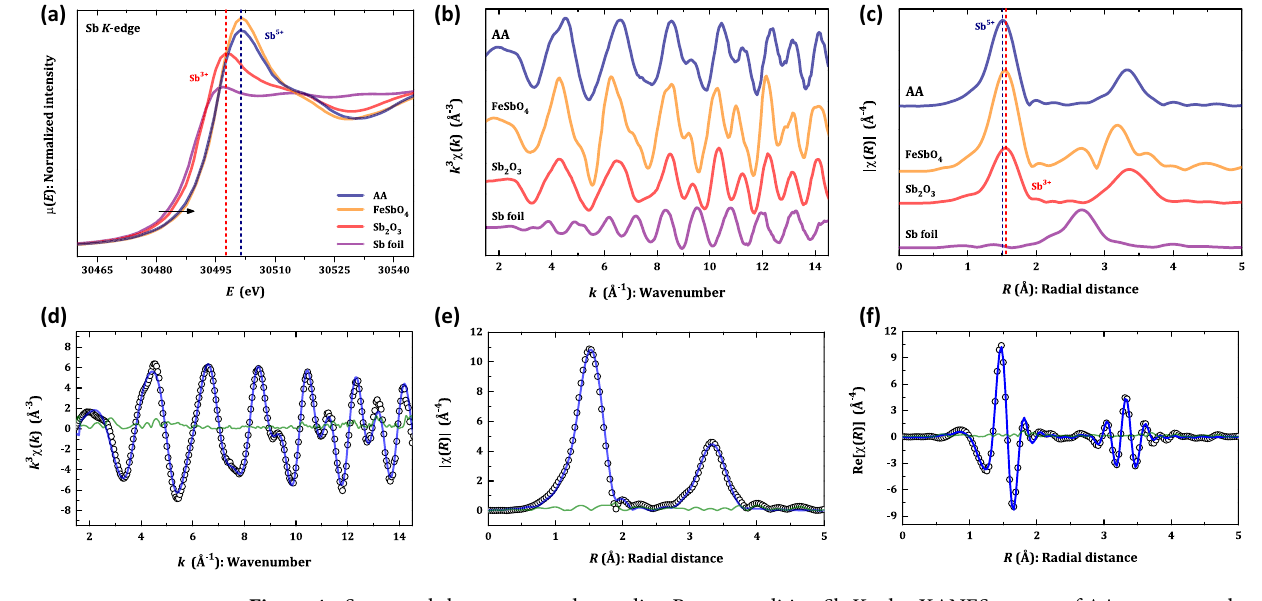
Figure 4. Structural short-range order studies. Room condition Sb K -edge XANES spectra of AA as compared with reference samples of Sb foil, Sb 2 O 3 , and FeSbO 4 ( a ). The k 3 -weighted EXAFS signals ( b ) and their corresponding moduli of the Fourier transform ( c ). The fitting was performed using the scattering paths in Table 4: the EXAFS oscillations k 3 χ ( k ) ( d ), moduli of the Fourier transform | χ ( R )| ( e ), and its real part Re[ χ ( R )] ( f ) in R space. The open symbol stands for the experimental point, the solid blue line is the best fit, and the green line the